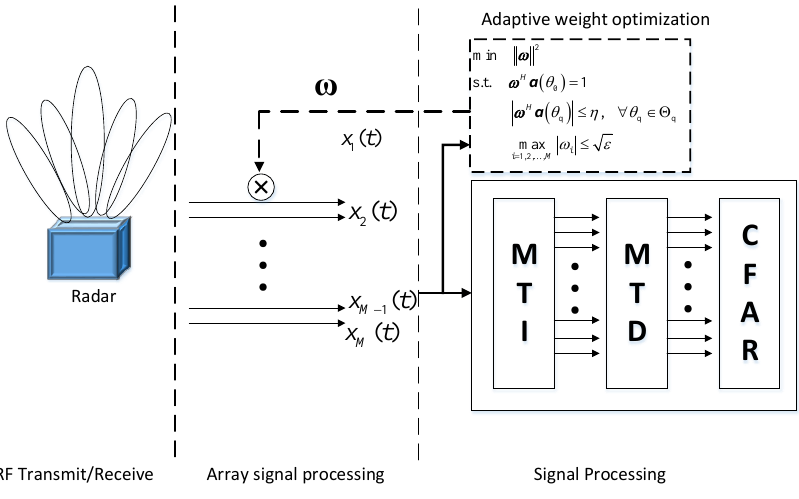
Figure 2. Array signal processing system diagram.